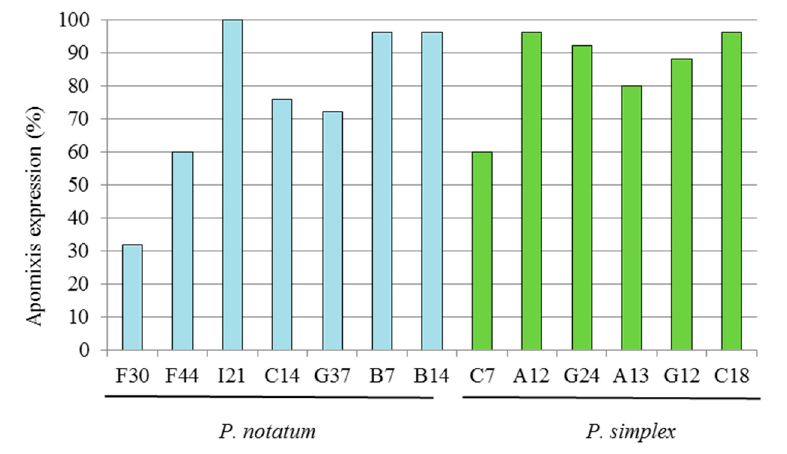
Figure 3. Expression of the apomixis (%) in the progeny of a group of highly apomictic hybrids from P. notatum and P. simplex .